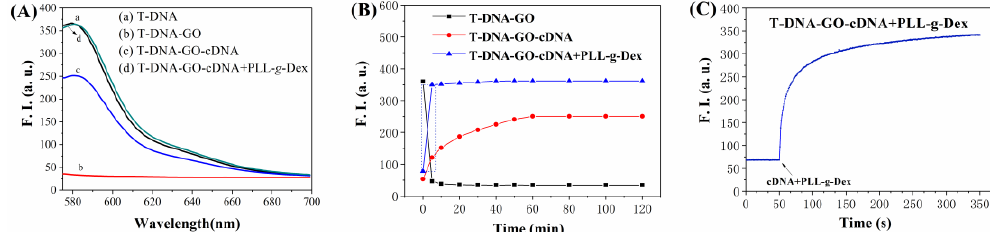
Figure 3. ( A ) The fluorescence intensity of T-DNA (20 nM) under the following conditions: (a) T-DNA in the solution; (b) T-DNA + GO (9 μg/mL); (c) T-DNA + GO (9 μg/mL) + cDNA (90 nM); and (d) T- DNA + GO (9 μg/mL) + cDNA (90 nM) + PLL- g -Dex (96 nM). ( B ) The fluorescence intensity of T-DNA